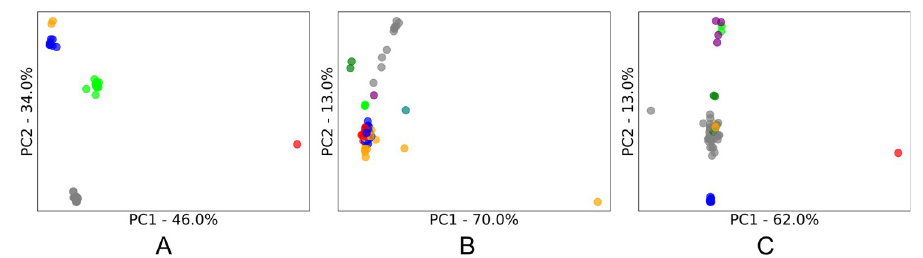
Fig 2. PC1 vs PC2 PCA score plots of the clusters present in the explosives spectroscopy datasets. A: Output Energetic; B: Transition Energetic; C: First Fire Energetic. The percentage of original information contained in each principal component is shown on each